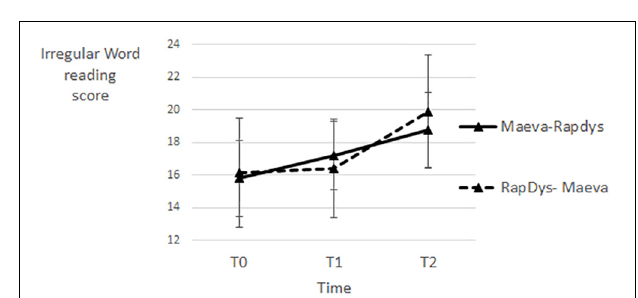
FIGURE 8 | Irregular word reading scores for each time period and each presentation